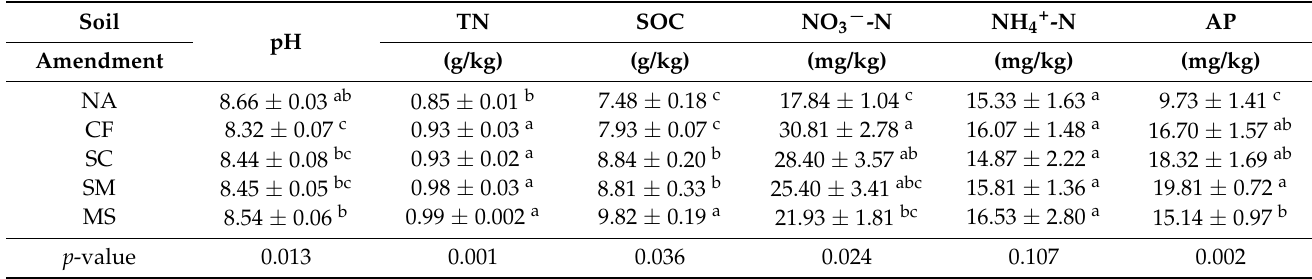
Table 3. Soil physiochemical properties as influenced by soil amendments at flowering stage of corn.